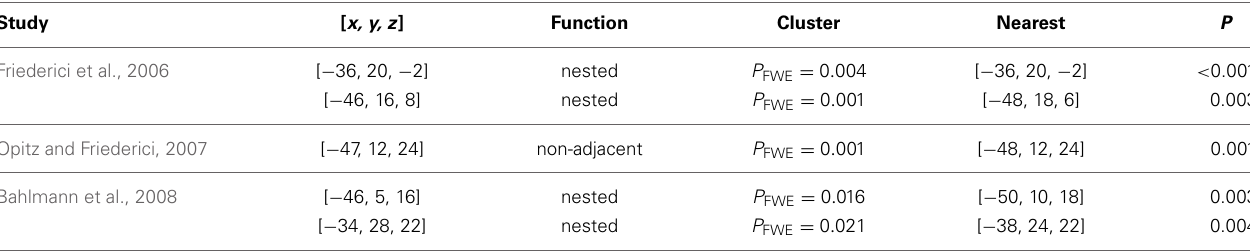
Table 2 | Overlap between the activated clusters in the listed studies and the clusters that we found activated in the left inferior frontal region related to the learning effect (Figure 7).